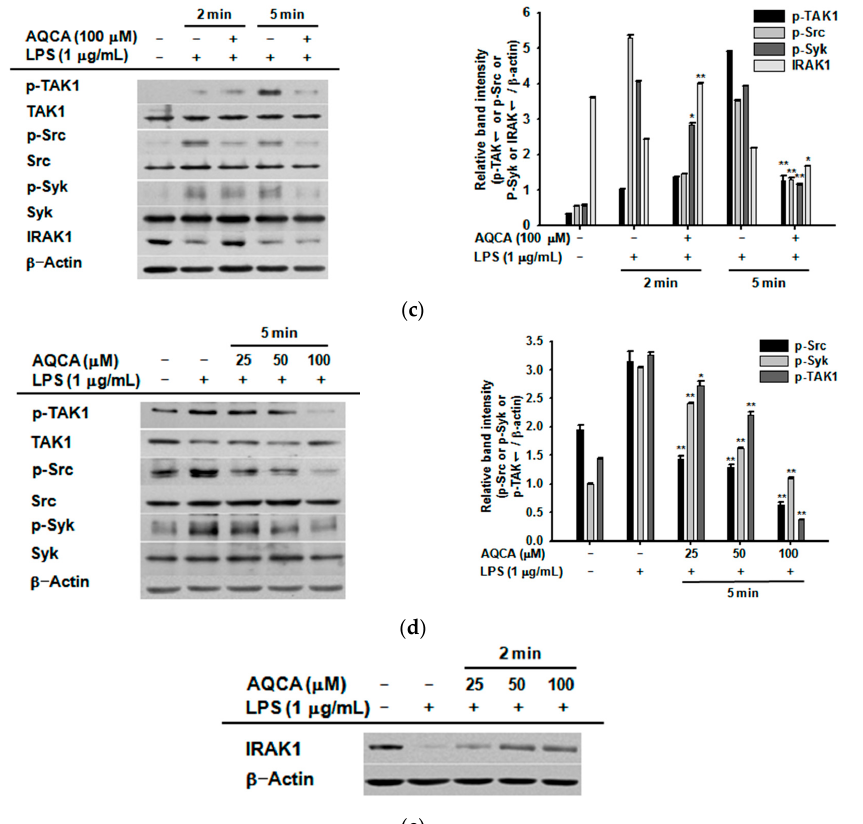
Figure 3. Effect of AQCA on nuclear factor (NF)- κ B and activator protein (AP)-1 activation signaling. (Left panels of a – e ) RAW264.7 cells (5 × 10 6 cells/mL) were incubated with LPS (1 μ g/mL) in the presence or absence of AQCA (25, 50, or 100 μ M) for the indicated times. The levels of total or phosphorylated I κ B α , I κ B kinase α / β (IKK α / β ), IKK β , protein kinase B (AKT), transforming growth factor β -activated kinase 1 (TAK1), spleen tyrosine kinase (Syk), Src, interleukin-1 receptor-associated kinase 4 (IRAK1), c-Jun N-terminal kinase (JNK), extracellular signal–regulated kinase (ERK), p38, mitogen-activated protein kinase kinase 3/6 (MKK3/6), and β -actin in whole cell lysates were